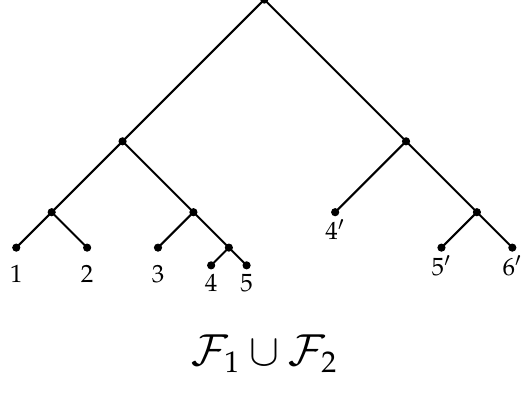
Figure 2. (cid:101) U 1 is the fixator of the tree F 1 ∪ F 2